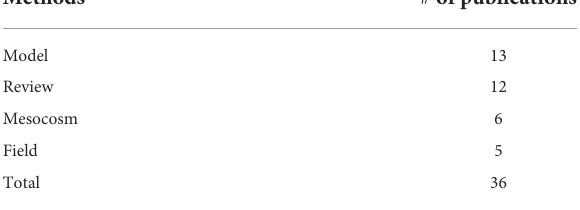
TABLE 1 Literature survey results for publications that examined enhanced weathering as a method for carbon dioxide removal, categorized by methodology used in the publication (see methods in section Literature survey of enhanced weathering study methodology and context).